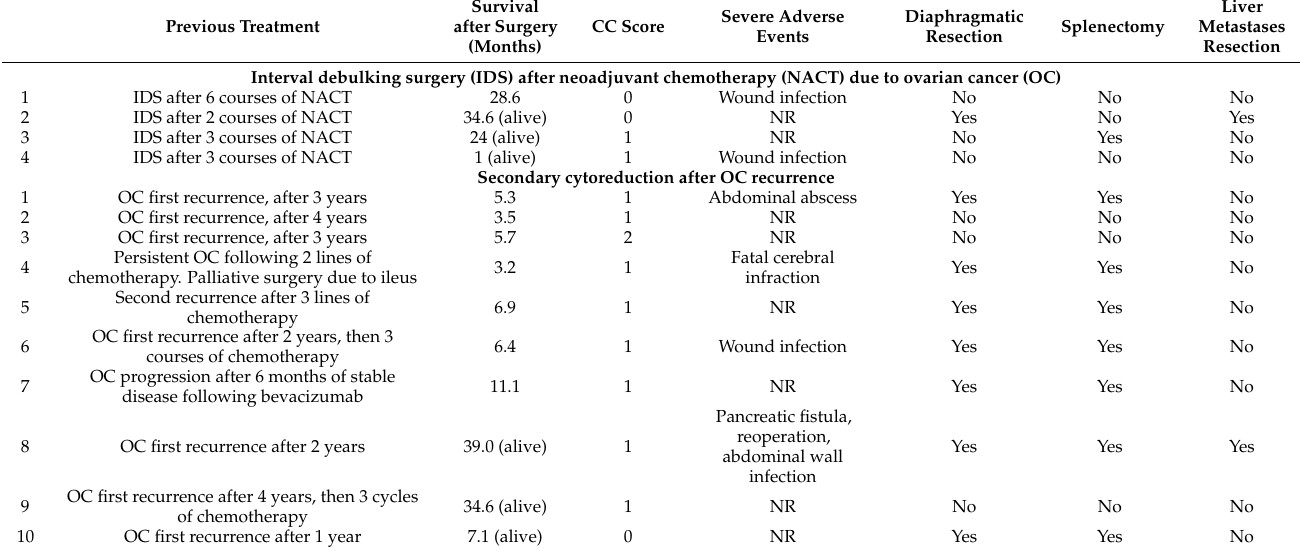
Table 3. Characteristics of the OC patients who underwent TC as a part of surgical treatment during interval debulking surgery or secondary surgery due to cancer recurrence. Survival Previous Treatment after Surgery CC Score Severe Adverse Events Diaphragmatic Resection Splenectomy (Months)